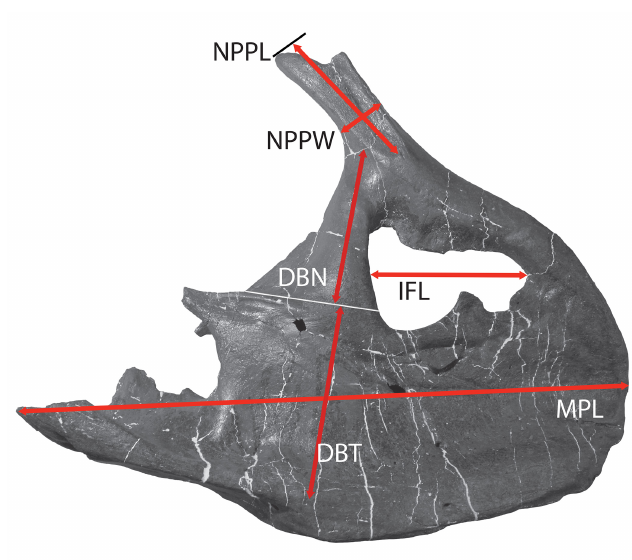
Figure 4. Measurement parameters for MOR 1122 7-22-00-1. Measurements presented in Table 1. Abbreviations: NPPL, nasal process of the premaxilla length; NPPW, nasal process of the premaxilla width; IFL, interpremaxillary fenestra length; DBN, dorsoventral breadth of narial strut; DBT, dorsoventral breadth of triangular process; MPL, maximum preserved length.